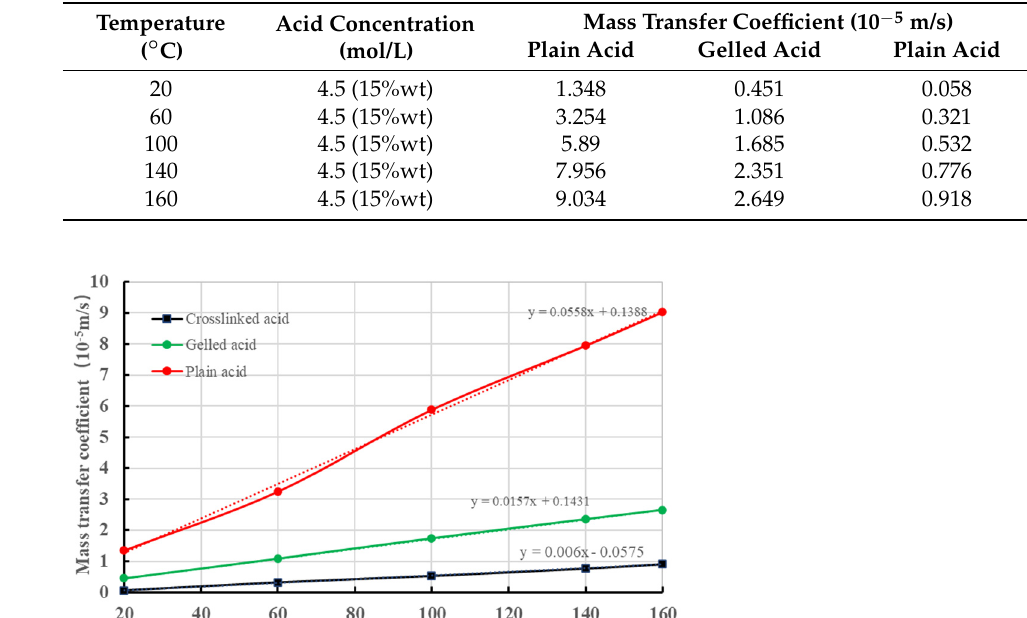
Table 3. Variation in mass transfer coefficients with temperature for three commonly used acids in the field.